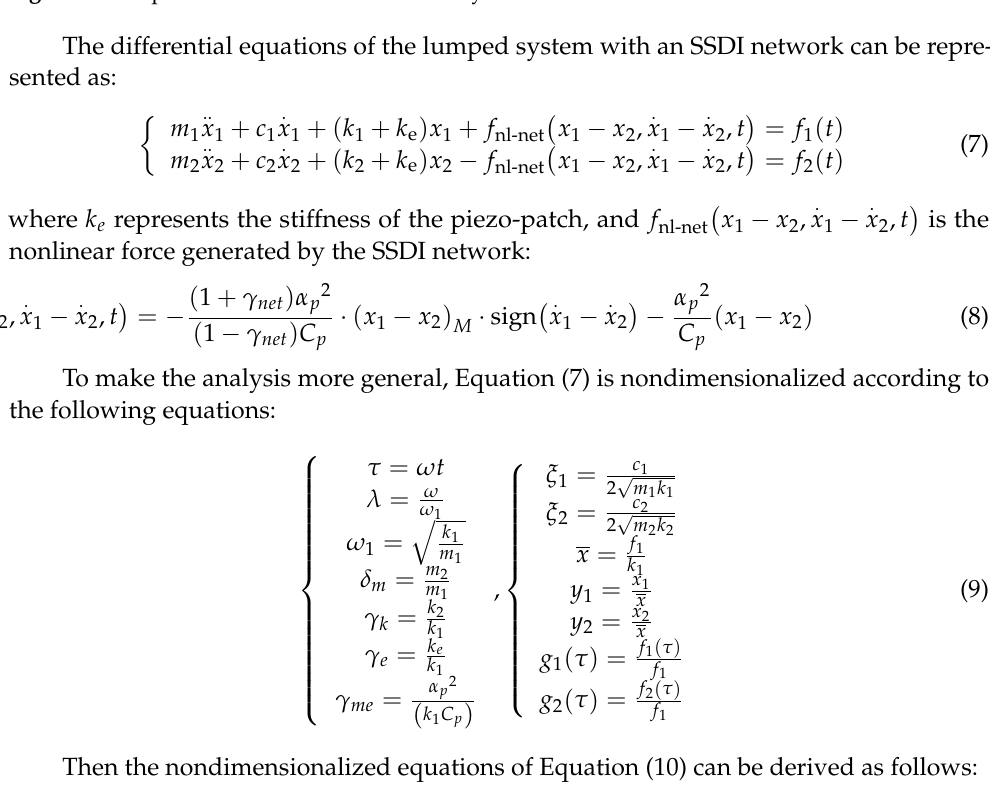
Figure 4. Lumped model of the double-beam system.